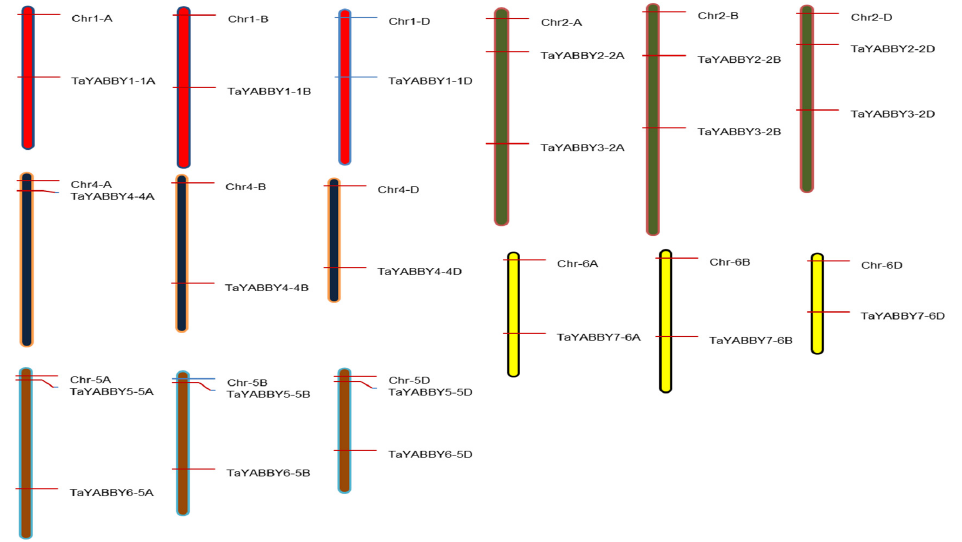
Figure 4. Chromosomal mapping of TaYABBY genes .